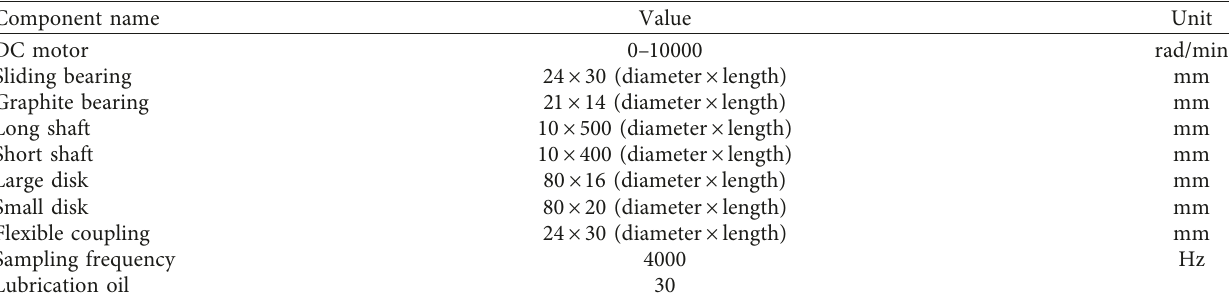
Figure 4: Rotor test rig. Table 2: Main parameters of the two-span rotor-bearing